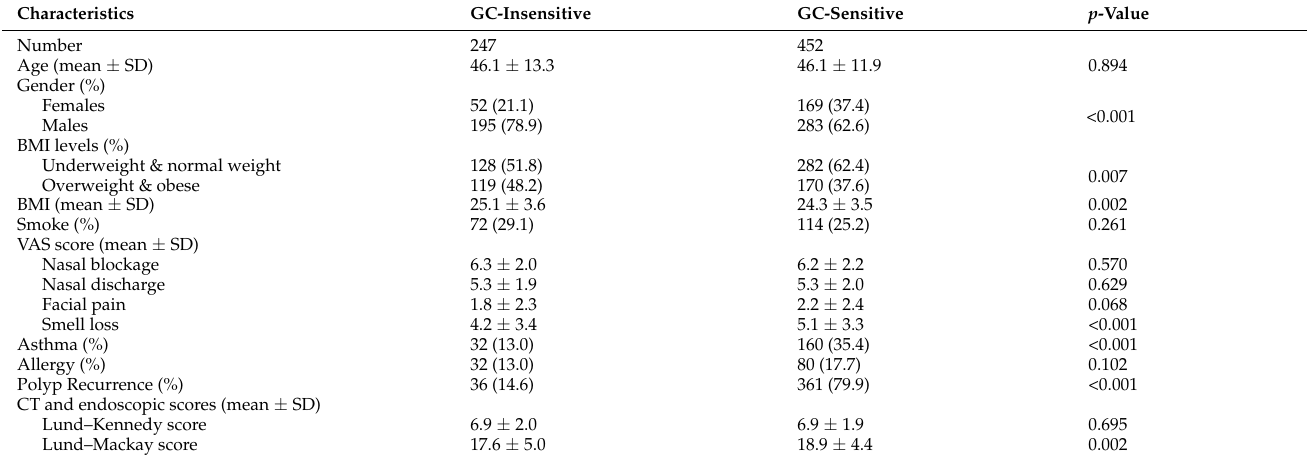
Table 1. Characters of glucocorticoid (GC)-insensitive and sensitive CRSwNP patients.